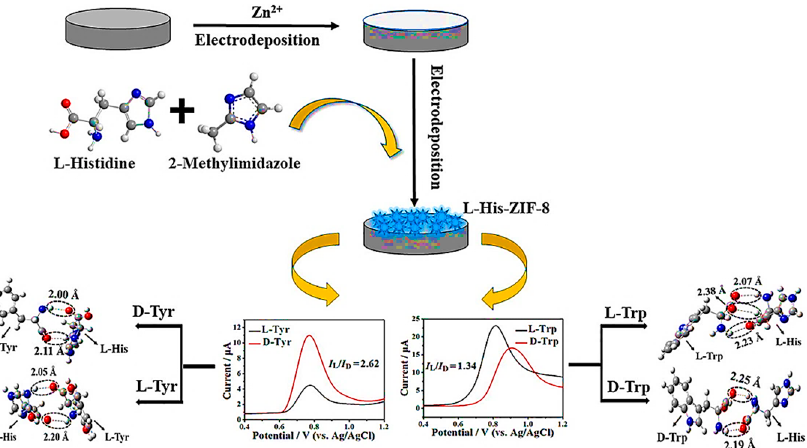
Figure 10. Schematic representation of preparation procedure of L-His-ZIF-8/GCE for electrochemical chiral sensing and of tryptophan and tyrosine isomers. Reprinted (adapted) with permission from [91]. Table 1. Analytical performances of MOF-based enantioselective sensors.